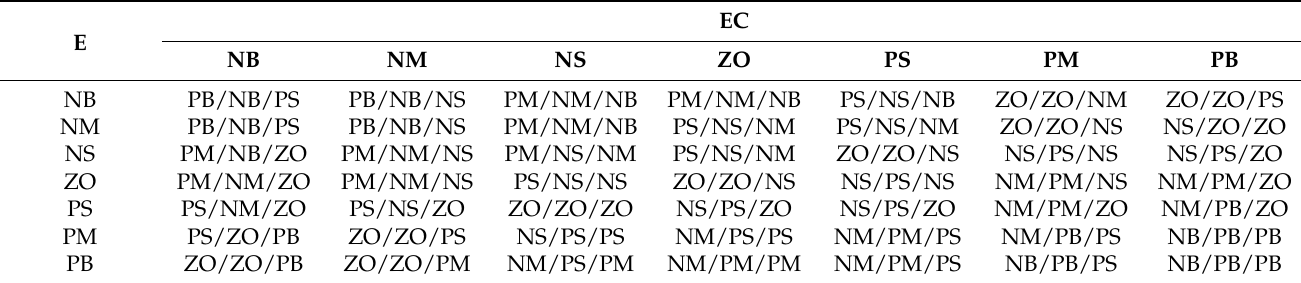
Table 1. Table of the fuzzy control rules ( ∆ K p / ∆ K i / ∆ K d